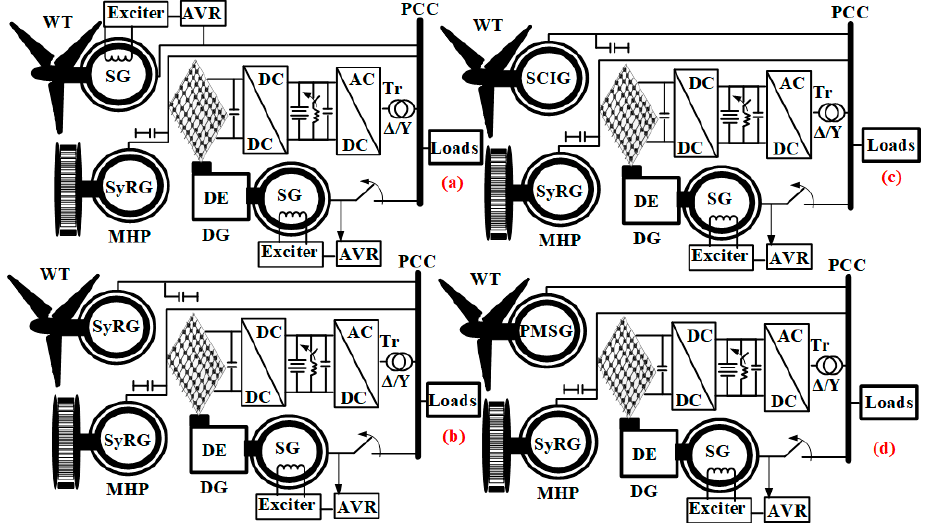
Figure 7. Off-grid configurations having SPVA, MHP driven SyRG, DE driven SG, and WT driven: ( a ) SG, ( b ) SyRG, ( c ) SCIG, and ( d ) PMSG. ( a ) SG, ( b ) SyRG, ( c ) SCIG, and ( d )